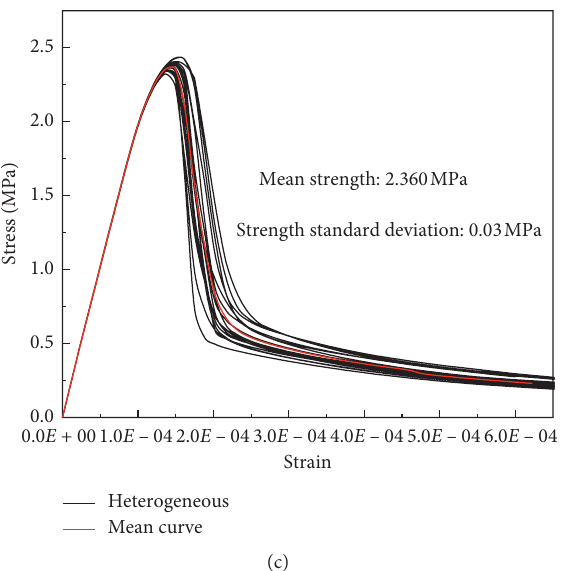
Figure 20: Stress-strain curves of rubber replacing sand models. (a) Rubber replace 5% sand. (b) Rubber replace 10% sand. (c) Rubber replace 15% sand.